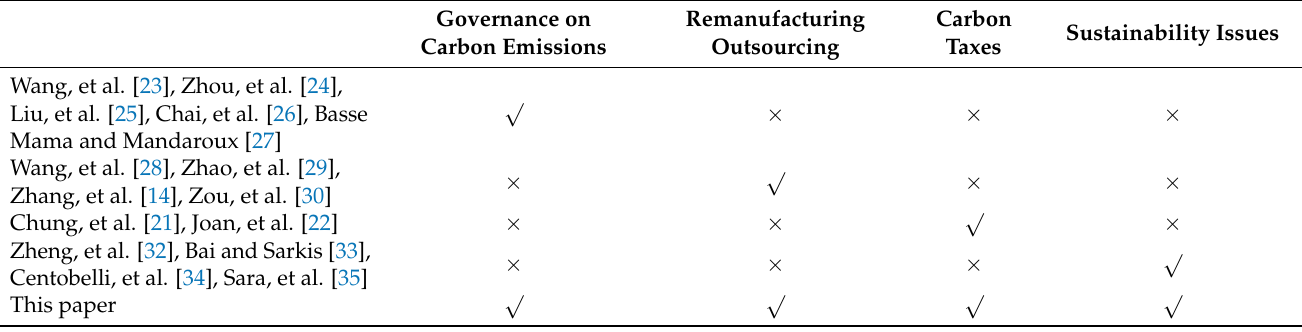
Table 1. A quick overview of our contributions to the literature. Governance